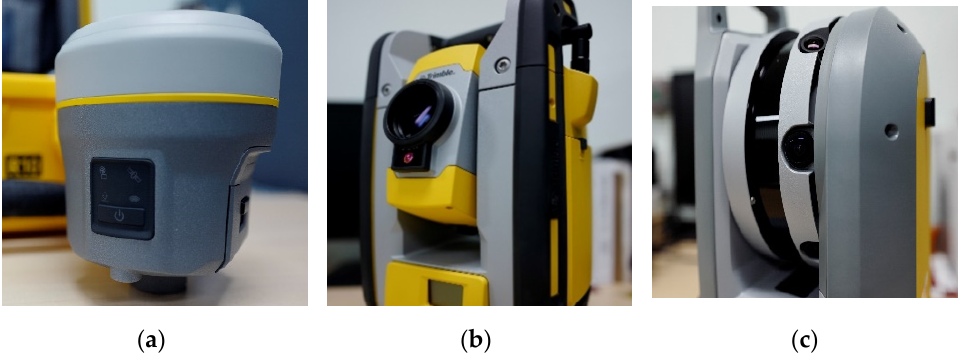
Figure 1. Equipment: ( a ) R10 (GNSS); ( b ) RTS-773 (total station); and ( c ) X7 (laser scanner).